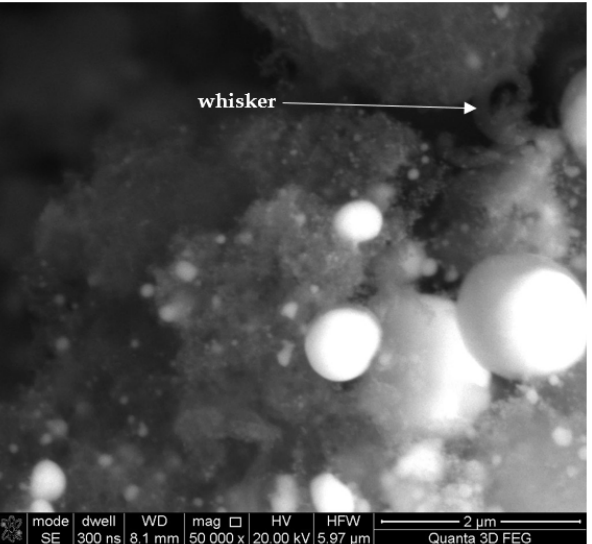
Figure 7. SEM image of the surface of the used catalyst. Magnification × 50,000. Power—25 W. Temperature—500 °C.